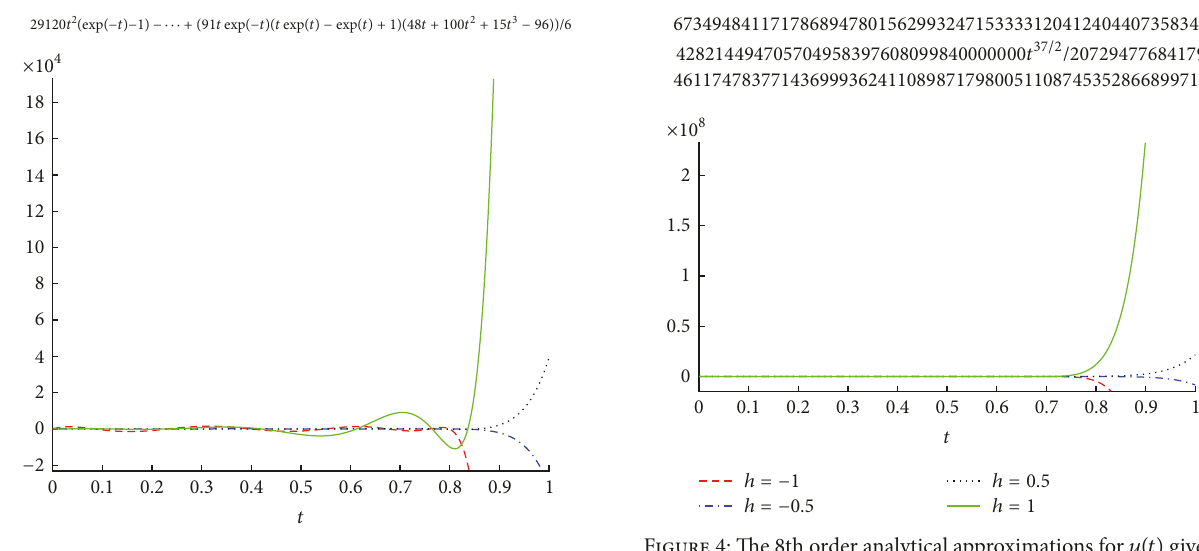
Figure 4: The 8th order analytical approximations for 𝑢(𝑡) given by HMA by considering the classical Caputo fractional